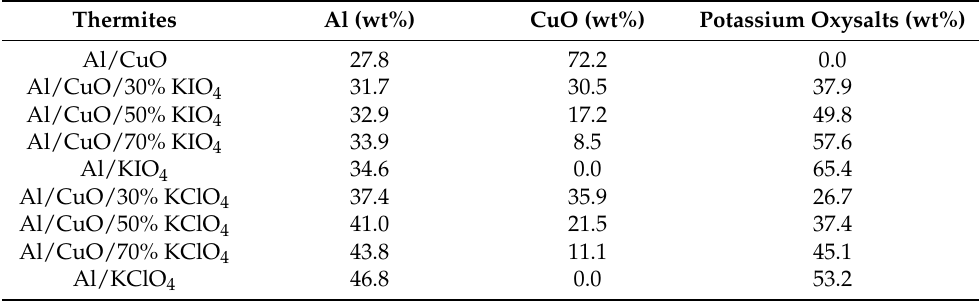
Table 1. Stoichiometric thermites formulation (Al/CuO/x potassium oxysalts).